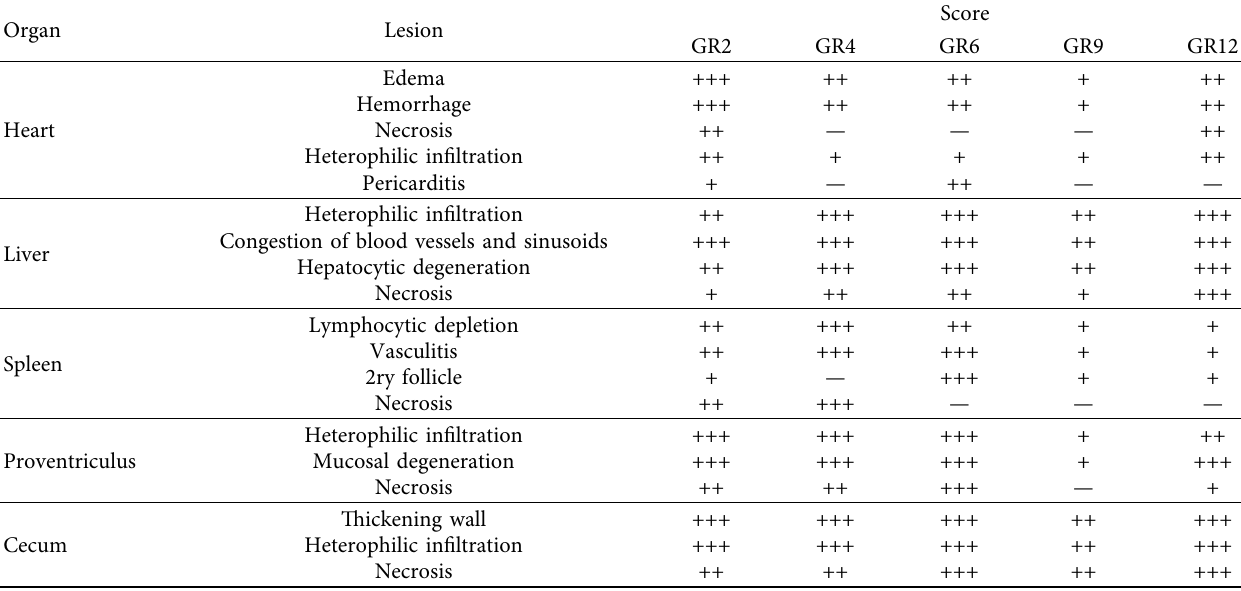
Table 10: Pathological lesions in groups treated with SXT strain 2 weeks after